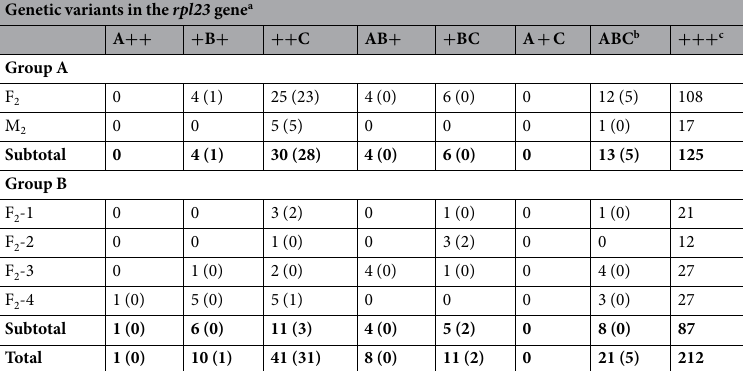
Genetic variants in the rpl23 gene a